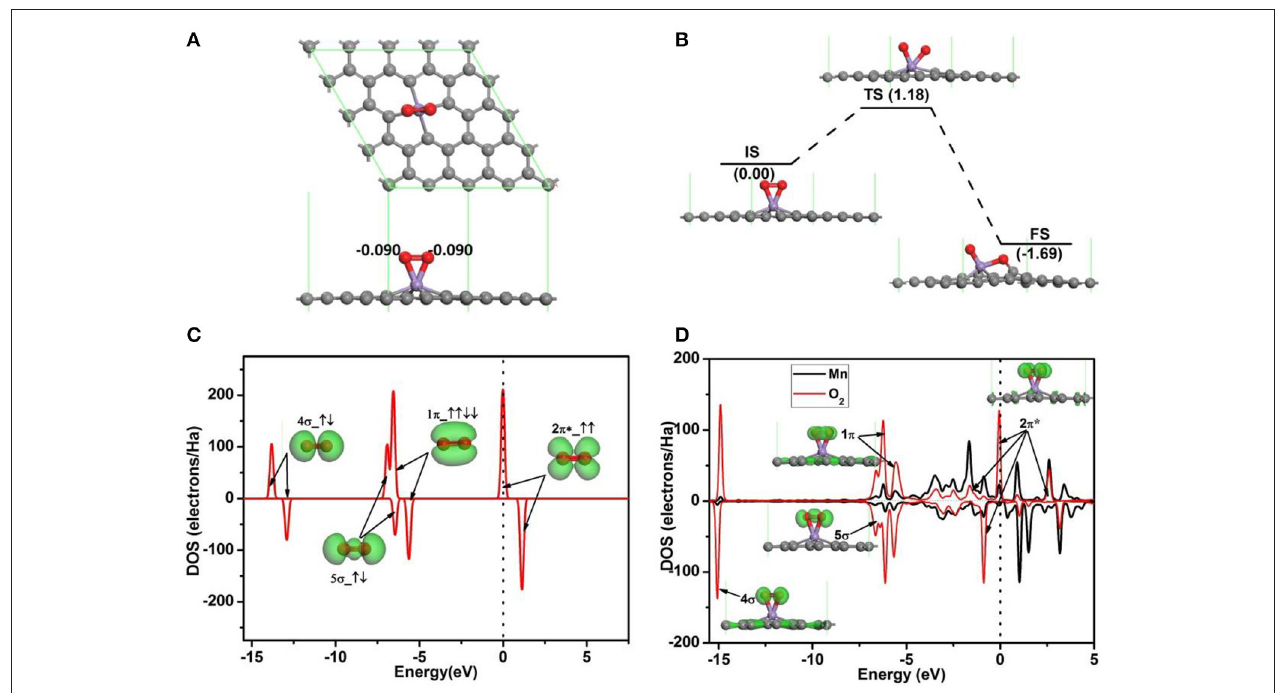
FIGURE 3 | (A) The most stable structure of O 2 adsorbed on Mn-DG. (B) The reaction pathway for the dissociative adsorption of O 2 molecule on Mn-DG. (C) PDOS and orbitals of the free O 2 molecule, where the number of electrons for each orbital is also shown by arrows. (D) PDOS of the adsorbed O 2 molecule and Mn atom for Mn-DG, inset is the charge density of 4s, 5s, 1p, and 2p* orbitals of the adsorbed O 2 molecule. The vertical lines indicate the Fermi